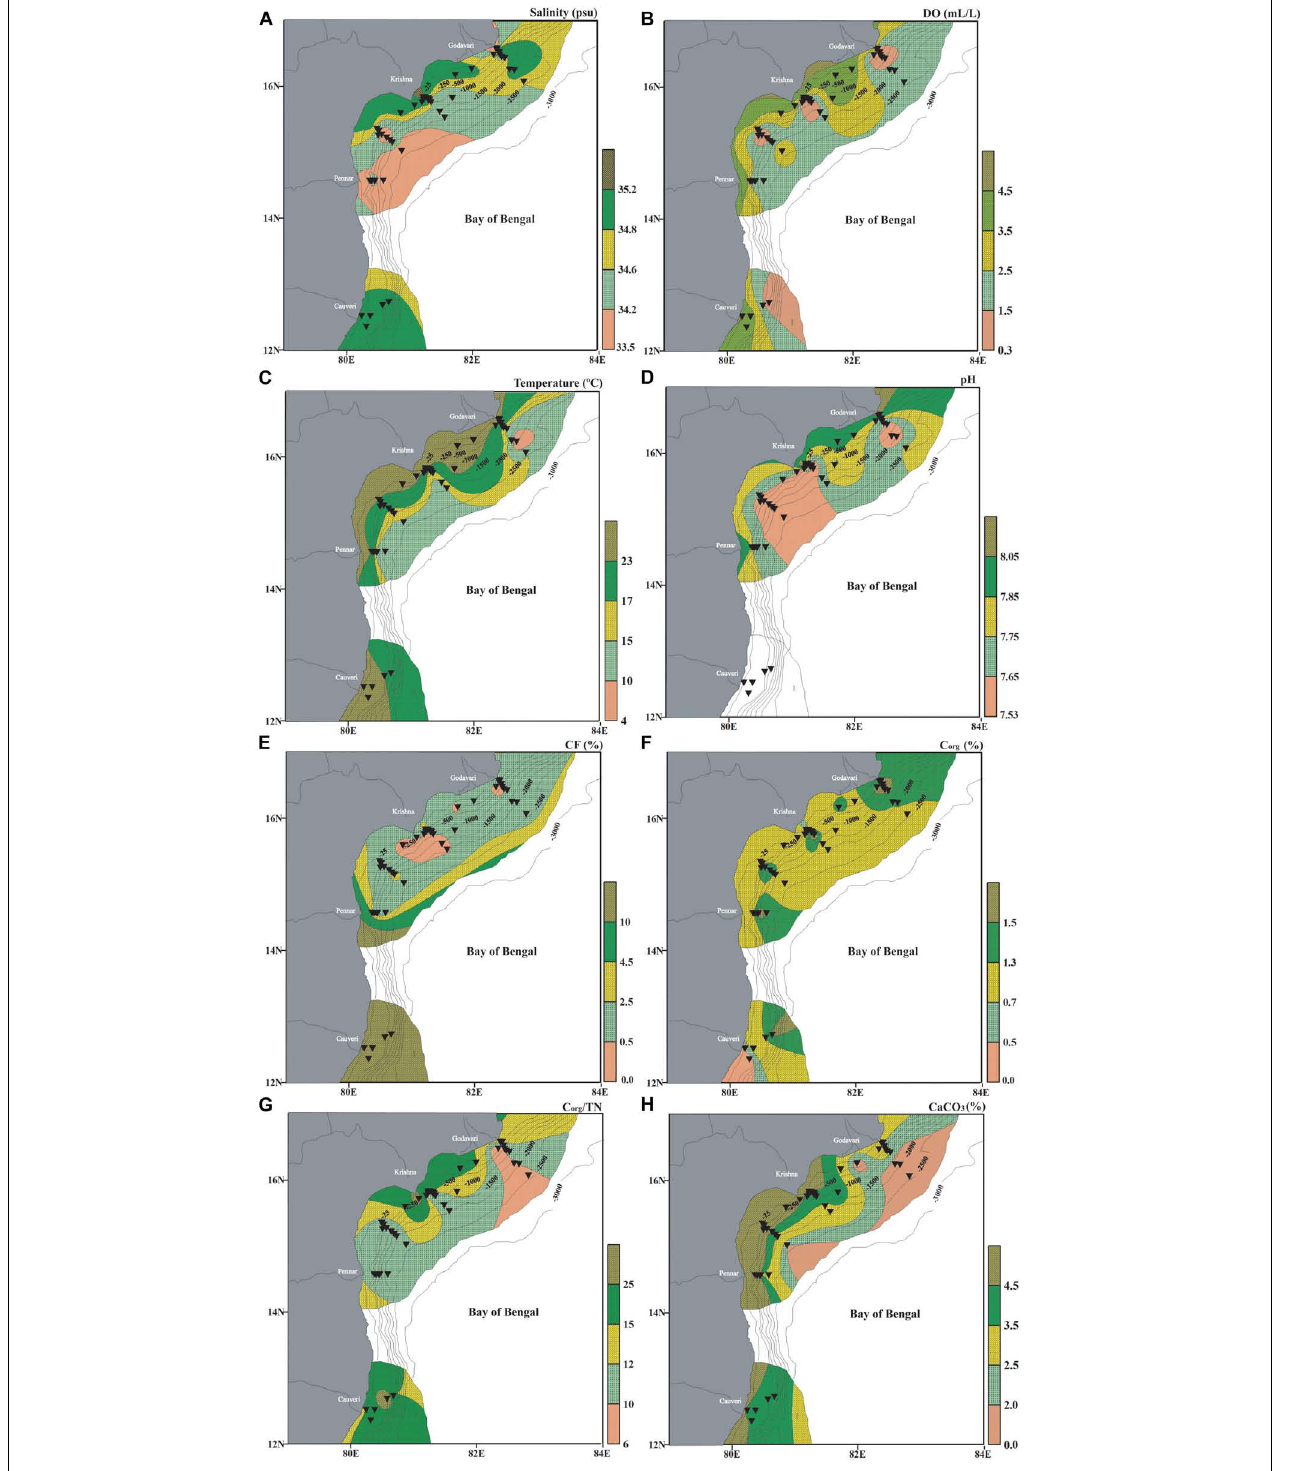
FIGURE 2 | Bottom water environmental parameters measured onboard from the water collected in multicores along with data downloaded from the World Ocean Atlas (Garcia et al., 2013; Locarnini et al., 2013; Zweng et al., 2013), and analyzed sediment characteristics in the western Bay of Bengal. (A) Salinity (psu), (B) dissolved oxygen (ml/l), (C) temperature ( ◦ C), (D) pH (The pH data in the southern part of the region is not available as we could not collect samples from the sediment-water interface), (E) coarse fraction (CF%), (F) organic carbon (%C org ), (G) organic carbon/total nitrogen (C org /TN) and (H) calcium carbonate (CaCO 3 %). The stations are marked by black inverted triangles. The thin black lines mark the bathymetric contours.